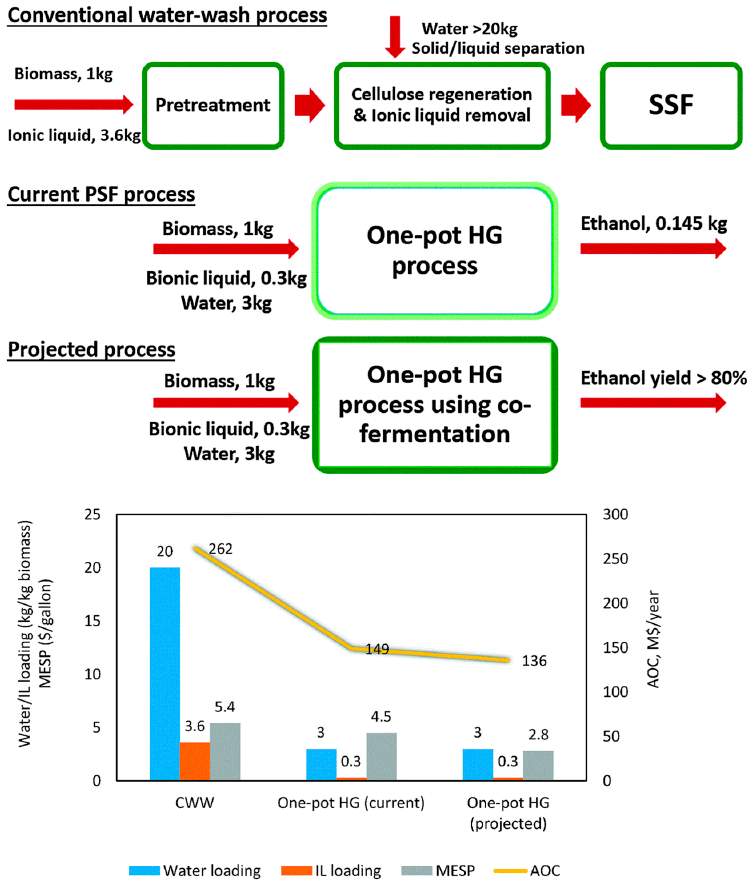
Figure 3. Comparison of three scenarios in terms of water loading, ionic liquid (IL) loading, annual operating costs (AOC), and minimum ethanol selling price (MESP). Scenario 1. The conventional ionic liquid process, including a water-washing step before simultaneous saccharification and fermentation (SSF); Scenario 2. One-pot high-gravity (HG) PSF (pretreatment, saccharification, and fermentation) configuration for ethanol production from glucose; Scenario 3. A projected system based on the current one-pot high-gravity configuration plus co-fermentation of ethanol from both glucose and xylose. Adapted from Reference [139] with permission from The Royal Society of Chemistry.